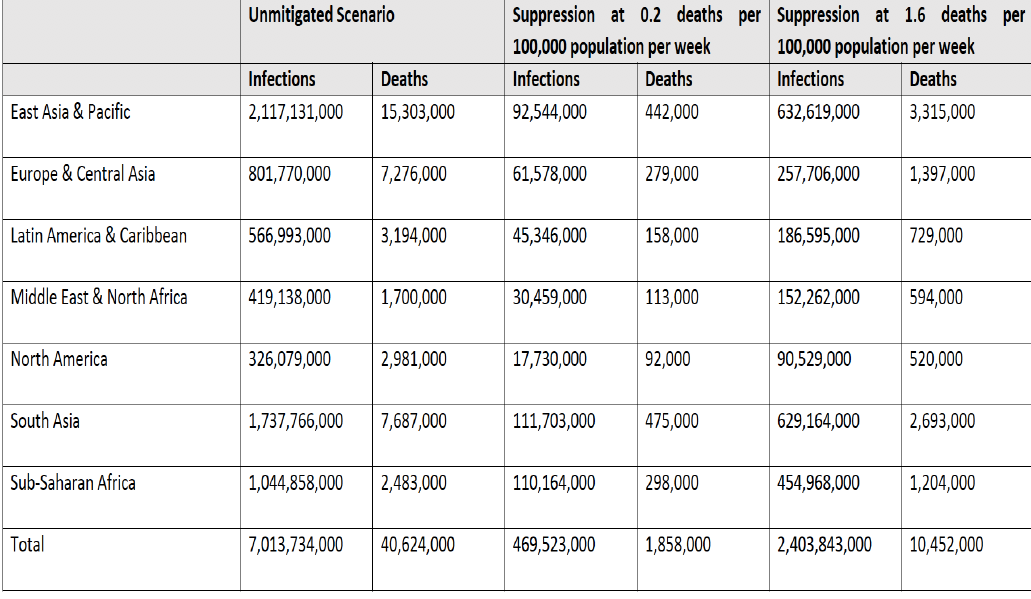
Table 1. COVID-19 world forecasts